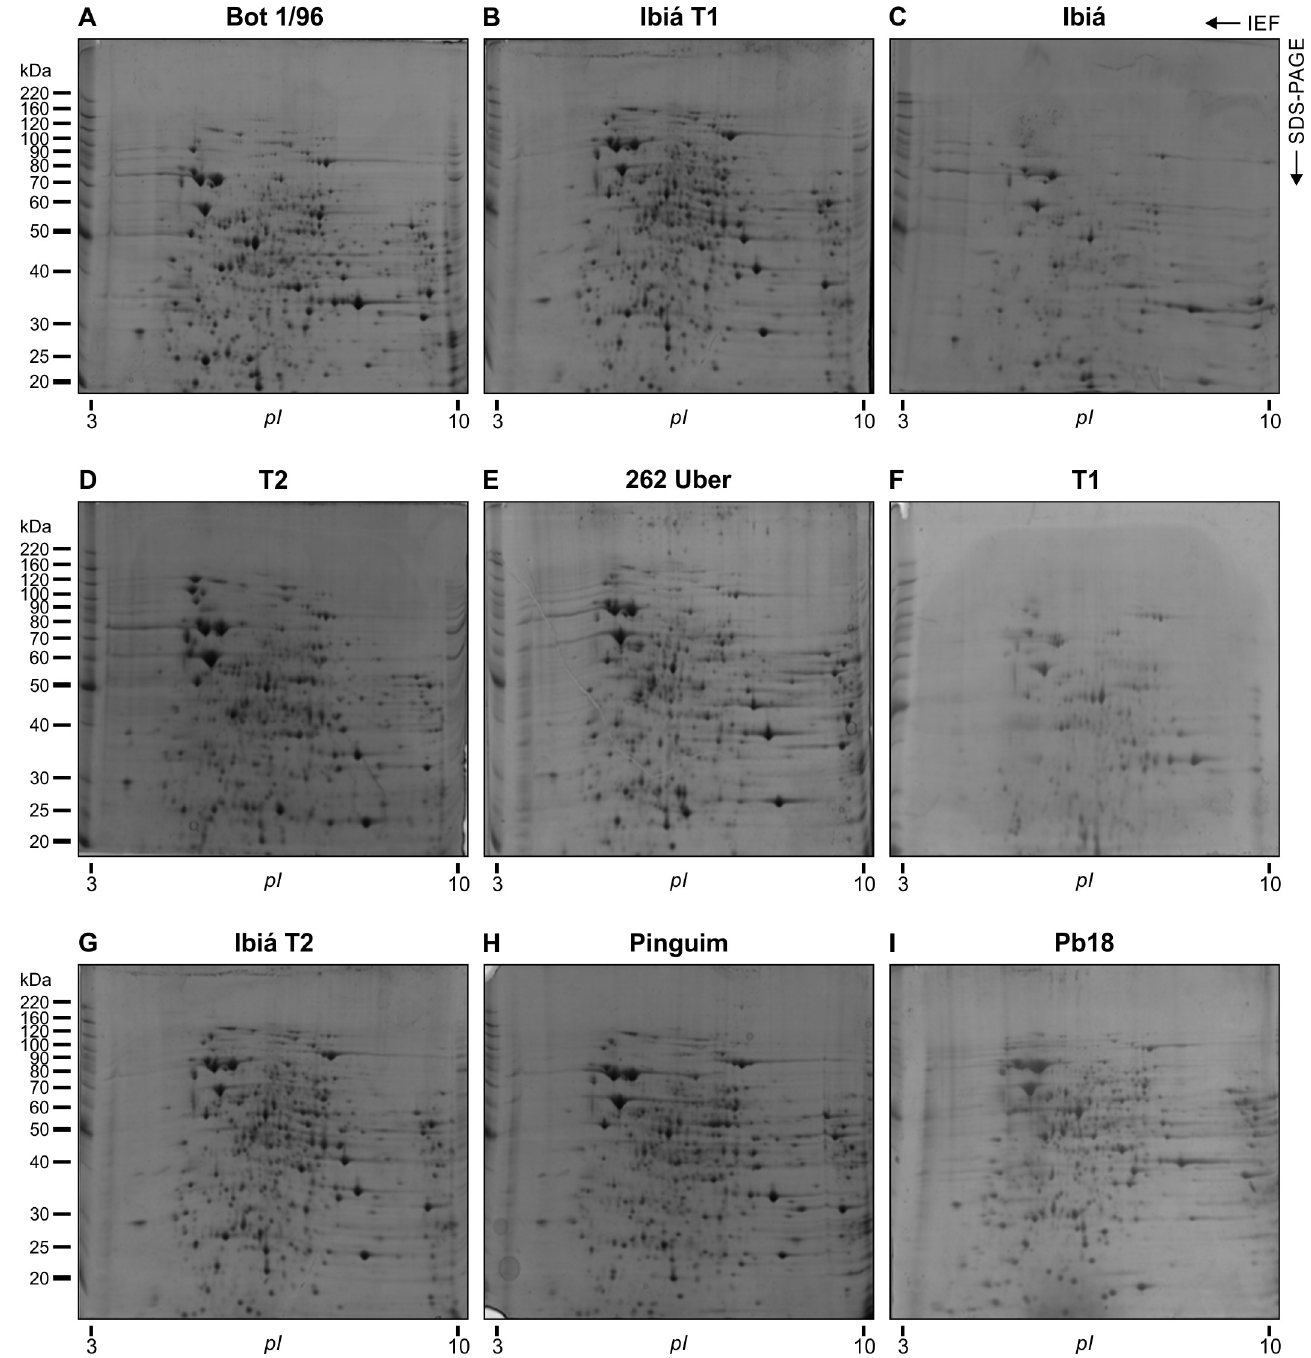
Fig 4. Proteomic maps of P . brasiliensis complex isolates. Cell extracts (originated from three biological replicates) were subjected to 2D electrophoresis on 13-cm immobilized pH gradient strips in the range of pI values from 3 to 10 (GE Healthcare, USA), and the proteins were developed by Coomassie blue staining. A representative 2D gel is shown for each Paracoccidioides isolate; a: Bot 1/96, b: Ibia´ T1, c: Ibia´, d: T2, e: 262 Uber, f: T1, g: Ibia´ T2, h: Pinguim, i: Pb18. Molecular masses of standard proteins are given on the left side of the gel (BenchMark Protein Ladder, Invitrogen). Further information about protein levels using 1D gel can be found in the S1